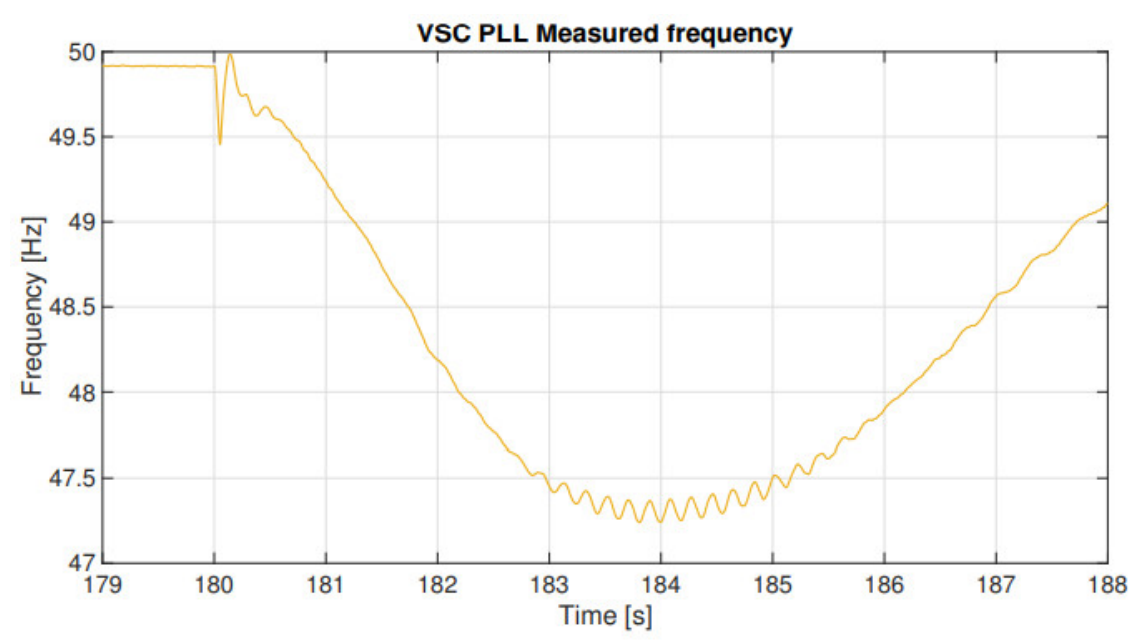
Figure 17. Source voltage measured frequency.